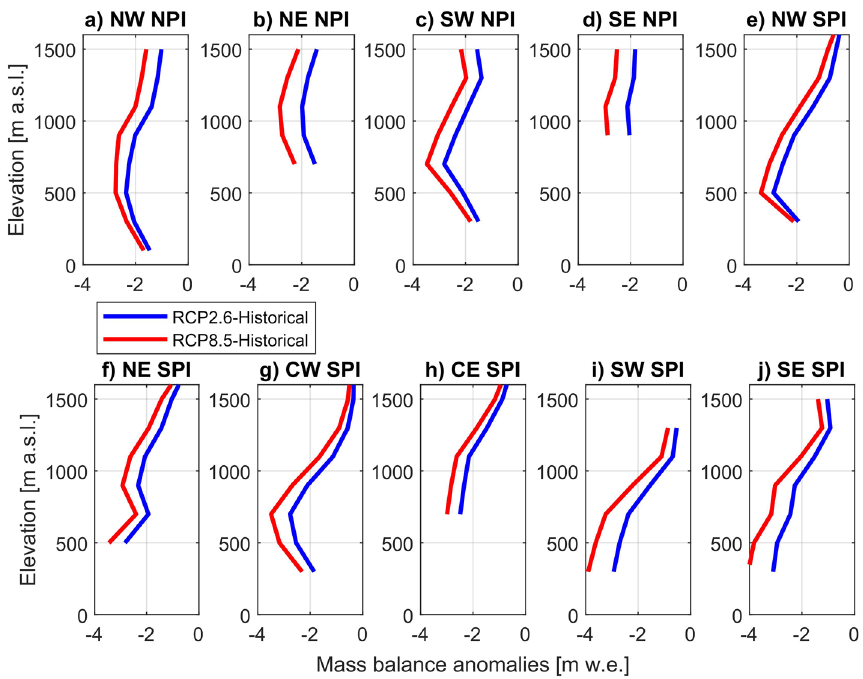
Figure 3. Surface mass balance differences per sub-zone (Fig. 1) and elevation range in both icefields. The differences were derived by comparing long-term SMBs between the historical period and each RCP